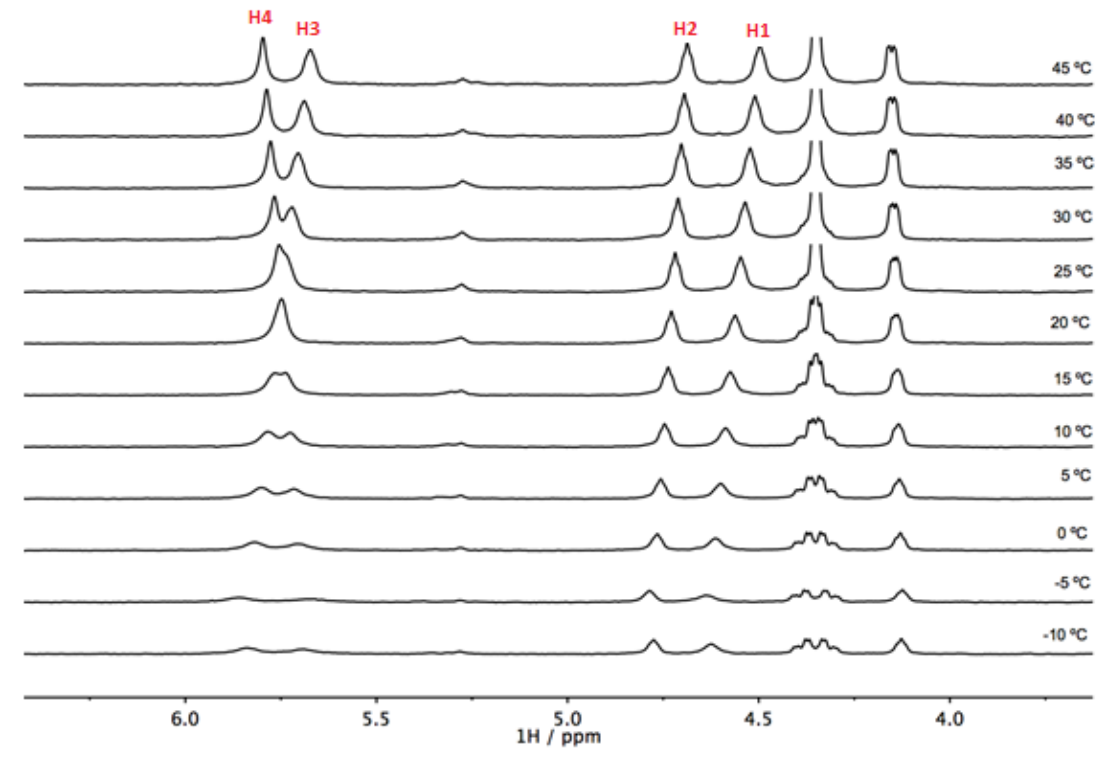
Figure 6. Variable temperature 1H NMR experiment of compound 3 . Temperatures, from bottom to top: − 10 to 45 °C (CDCl3, 500 MHz). The resonances of the H N . Table 2. Temperature coefficients of the H N protons of compound 3 .